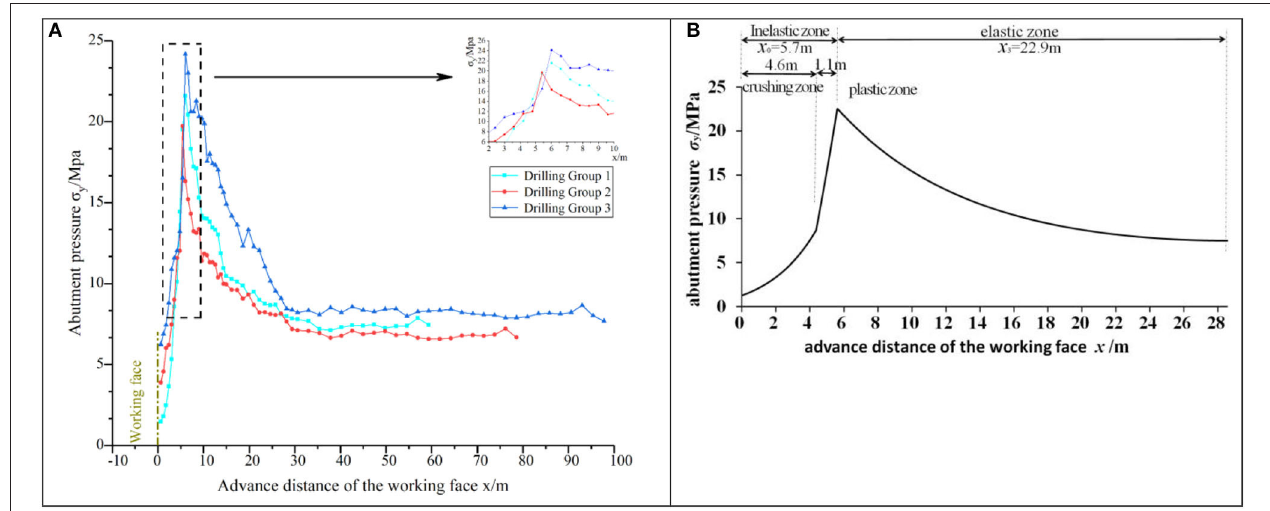
FIGURE 12 | Abutment pressure distribution curve. (A) Field monitoring of abutment pressure distribution. (B) Theoretical fit curve of the abutment pressure distribution.